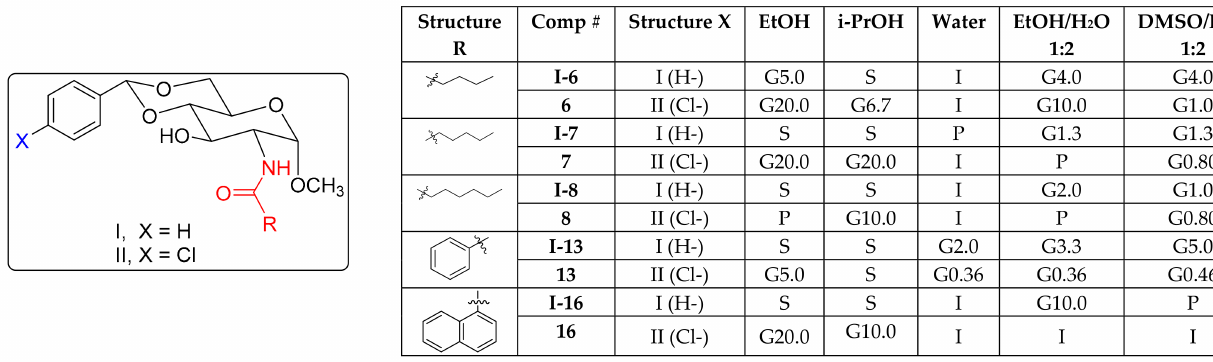
Figure 3. Comparison of gelation properties for several gelators with different functional